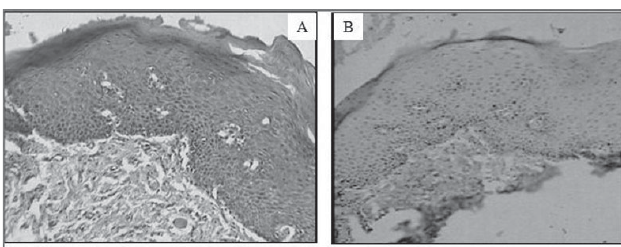
Fig. 4 H/E (A, 10X) and IHC staining with p53 expression (B, 4X) showing severe dysplasia.